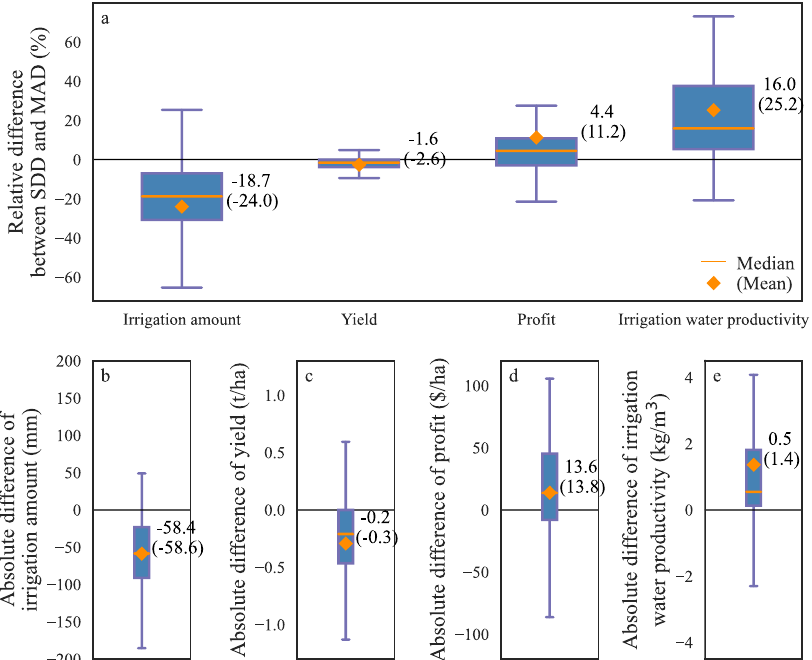
Fig. 5 Performances of plant-centric SDD and soil-moisture-based MAD irrigation schemes across 12 sites in Nebraska under current climate (2001- 2019). a The box plots of relative differences (see Methods) in irrigation amount, yield, pro fi t, and irrigation water productivity (ratio between yield and irrigation) between SDD and MAD across 228 site-years. b , c , d and e The box plots of absolute differences in irrigation amount, yield, pro fi t, and irrigation water productivity between SDD and MAD across 228 site-years. SDD and MAD irrigation schemes both used universal parameters across 12 sites in Nebraska. Boxes showed 25th – 75th percentiles, and the orange line and diamond denoted the median and mean for each box,